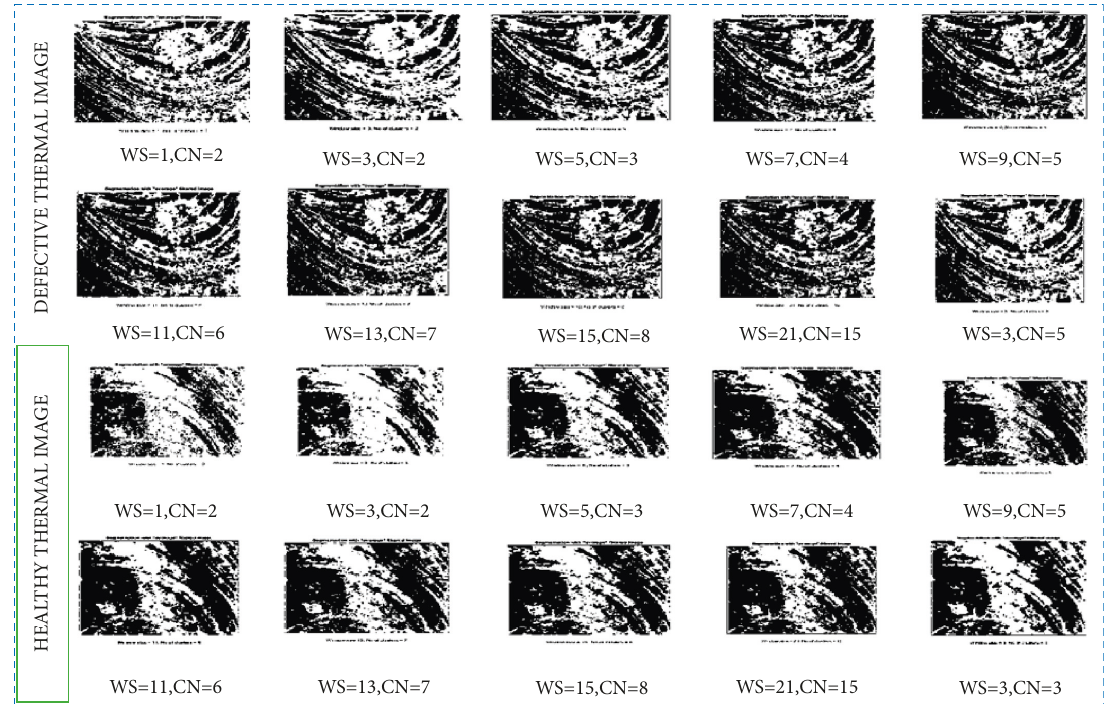
Figure 3: ARKFCM outputs using the average filter for defective and healthy thermal images.